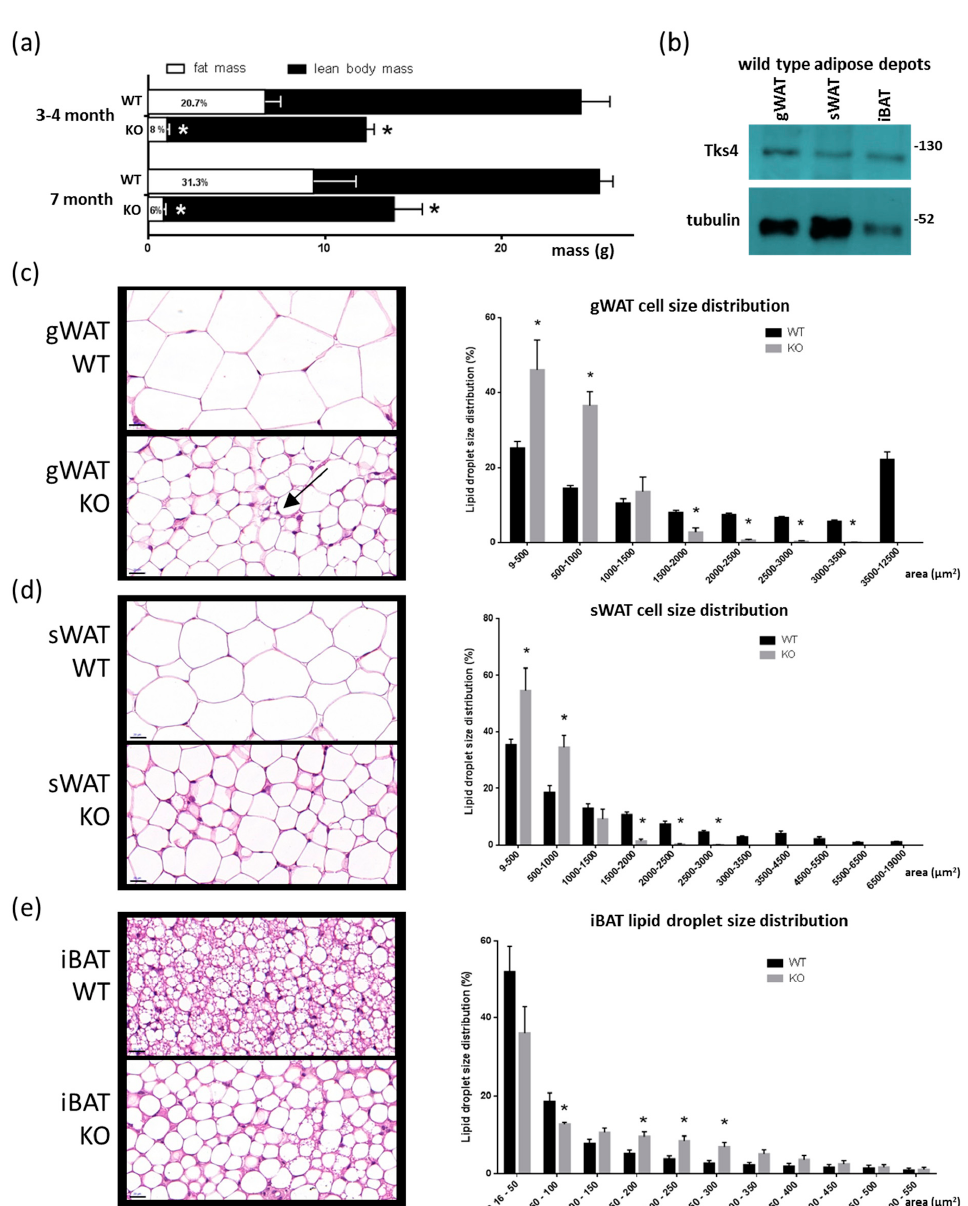
Figure 1. Adipogenic phenotypes of the Tks4-knockout (KO) mice. ( a ) Fat mass and lean body mass of 3–4- and 7-month-old wild-type (WT) and Tks4-KO mice as measured via EchoMRI. The numbers within the white columns indicate the normalized fat mass to body mass percentage. ( b ) Western blot-based detection of Tks4 in WT gonadal white adipose tissue (gWAT), subcutaneous WAT (sWAT), and interscapular brown adipose tissue (iBAT). Tubulin was used as the loading control. Representative hematoxylin and eosin (H & E)-stained ( c ) gWAT, ( d ) sWAT, and ( e ) iBAT sections from WT and Tks4-KO mice are shown on the left side. Scale bar: 20 µ m. The arrow indicates a multilocular cell islet among the white adipocytes in the Tks4-KO gWAT. Lipid droplet sizes were quantified, and size distribution diagrams are presented on the right side. Sections of six WT and six Tks4-KO mice were used, and four di ff erent fields-of-view from each mouse were analyzed. All data are presented as the mean ± SEM, and t -tests were applied to test statistical significance. * indicates p <